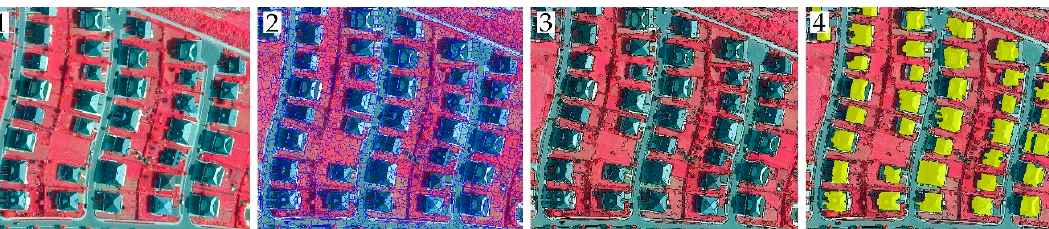
Figure 5. Stages of the GEOBIA building segmentation and classification in eCognition software (Trimble Geospatial); 1 —input data: CIR orthophoto; 2 —multiresolution segmentation; 3 —spectral difference segmentation; 4 —classification: buildings class.